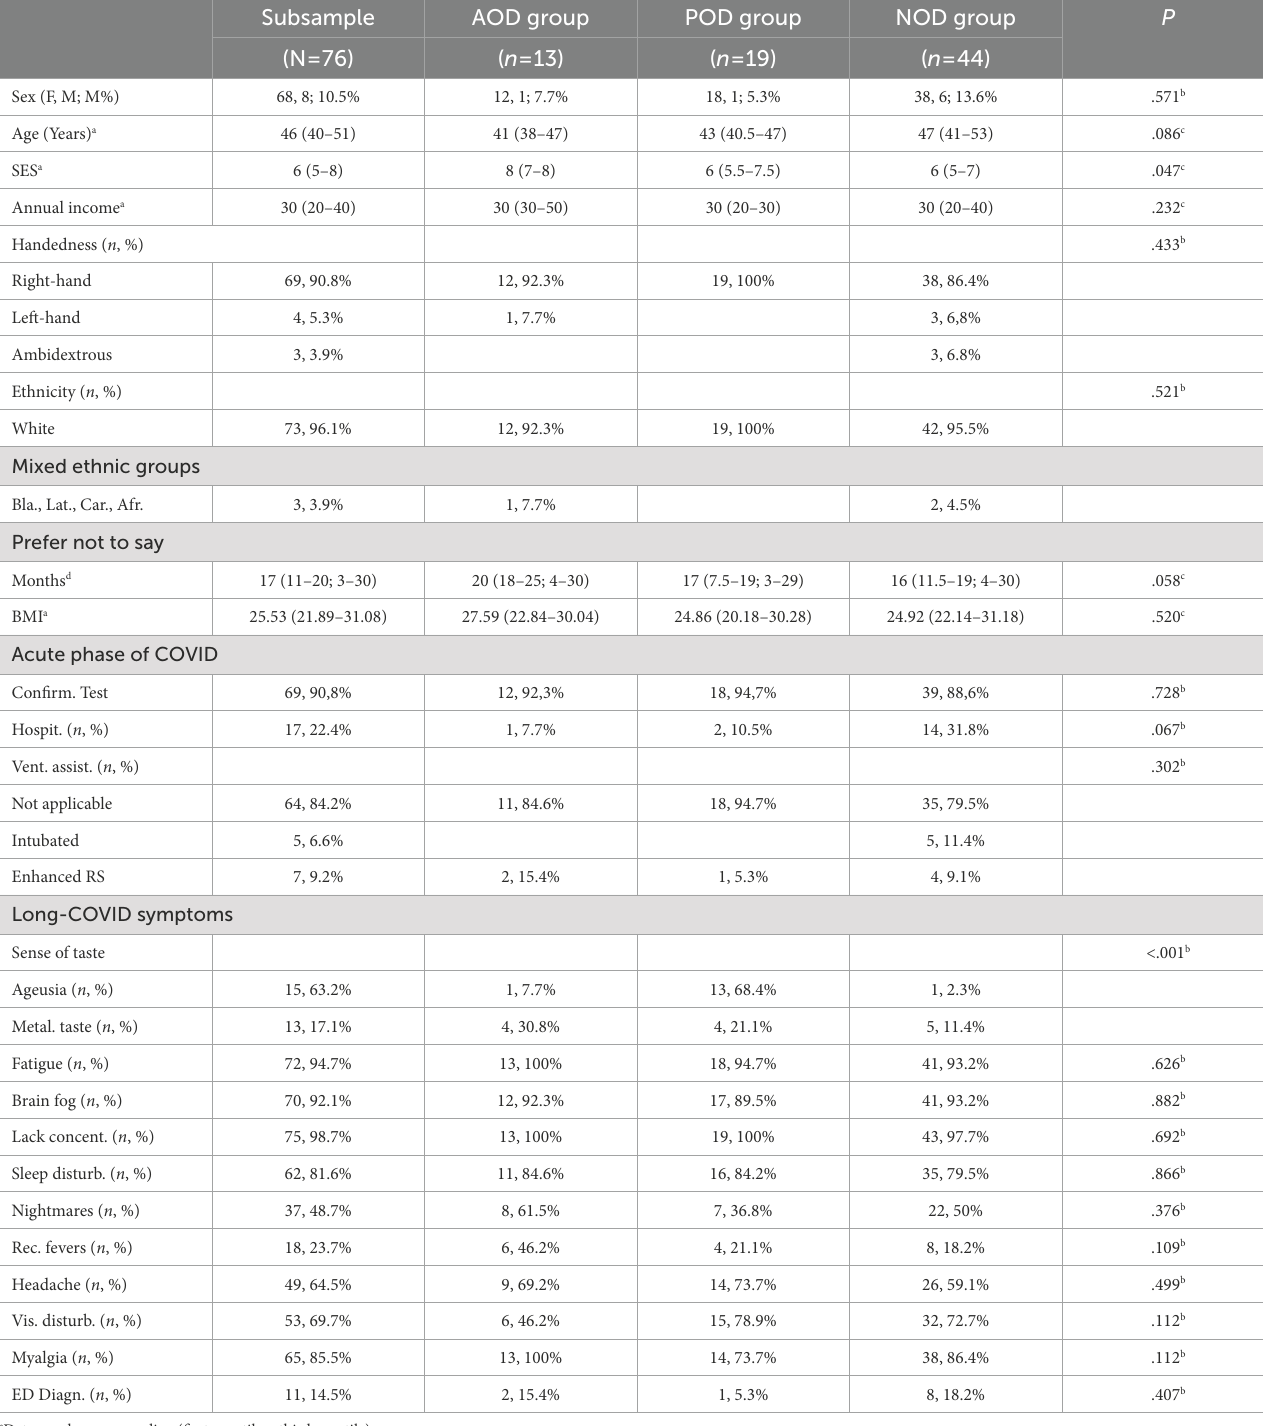
TABLE 2 Demographic information and clinical characteristics of the face-to-face assessed subsample related to the COVID history in the AOD, POD, and NOD groups. Subsample AOD group POD group NOD